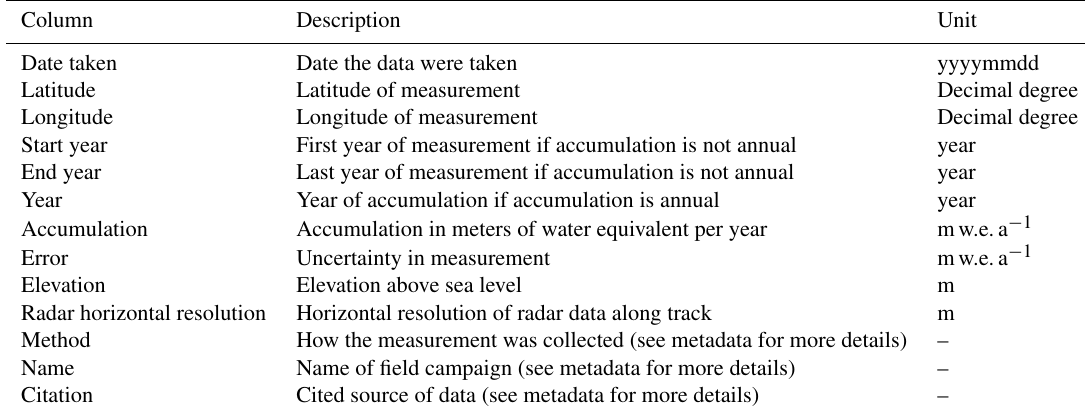
Table 2. The parameters for each snow accumulation measurement on land ice in the SUMup dataset with a brief description and the unit of